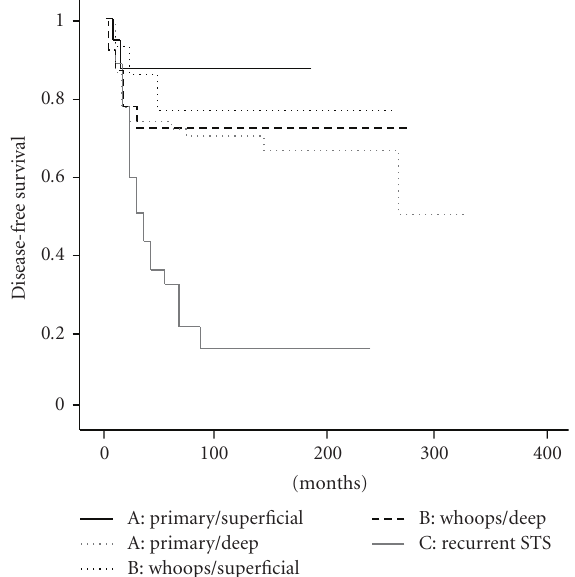
Figure 3: Kaplan-Meier curve of disease-free survival rates. Groups have been stratified according to tumour